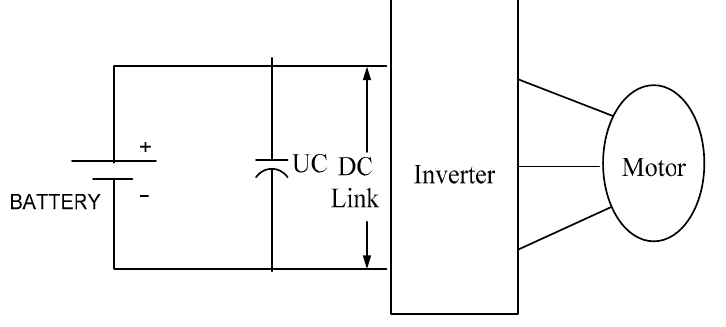
Figure 2. Passive parallel design.